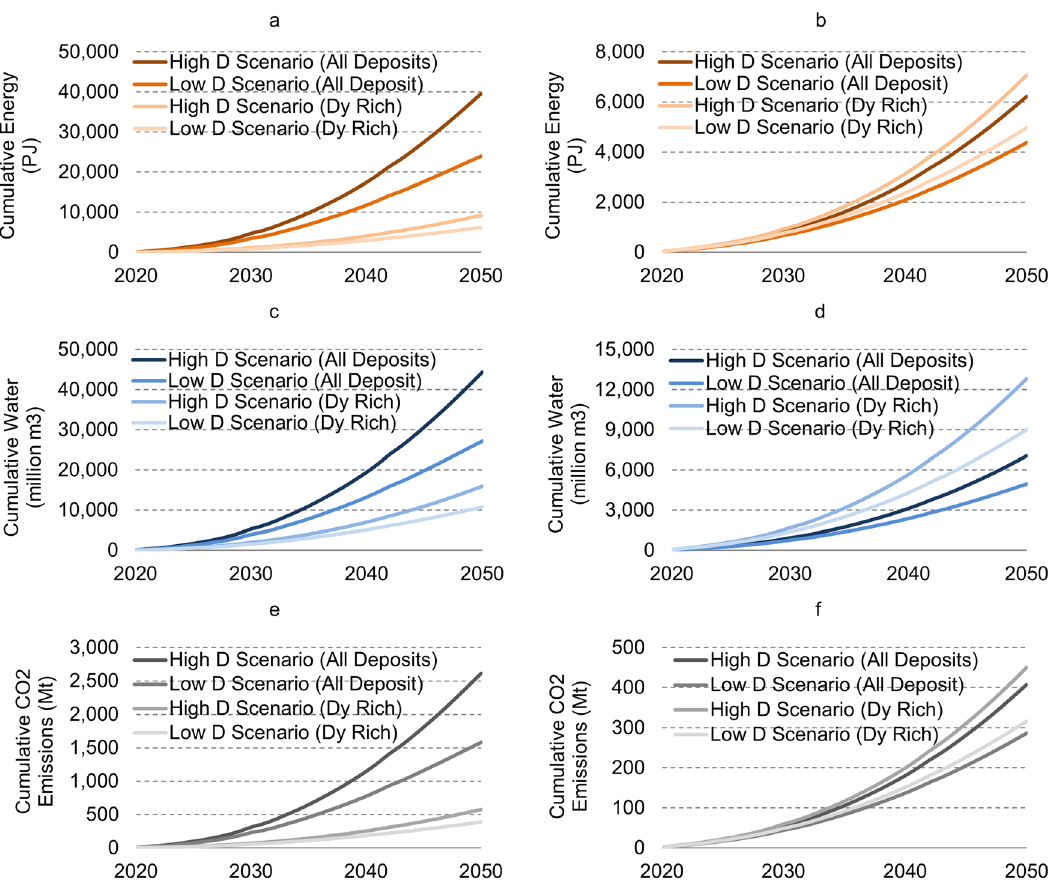
Fig. 8 Energy, water, and CO 2 emissions associated with oversupplied REEs and Dy and Nd demand in two demand scenarios and two primary supply scenarios. a , c , e Cumulative energy, water and CO 2 emissions associated with oversupplied REEs; and b , d , f cumulative energy, water and CO 2 emissions associated with Dy and Nd demand, in the high and low demand scenarios and two primary Dy supply